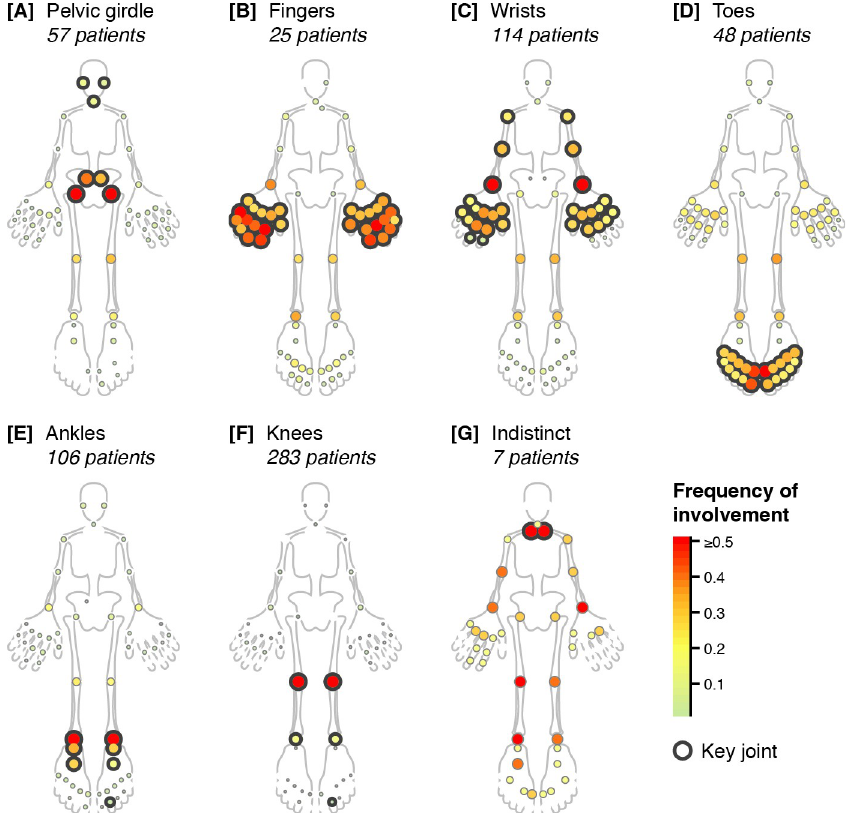
Fig 3. Distinct patterns of joint involvement. Homunculi of frequencies of involvement (colors; bottom-right legend) for individual joints (circles) for each patient group (panels) identified in the discovery cohort. White denotes a frequency of zero. Outlined joints represent key joints for high-level factors (S6 Fig) underlying each patient group. See Fig 1 for the identity of each joint.